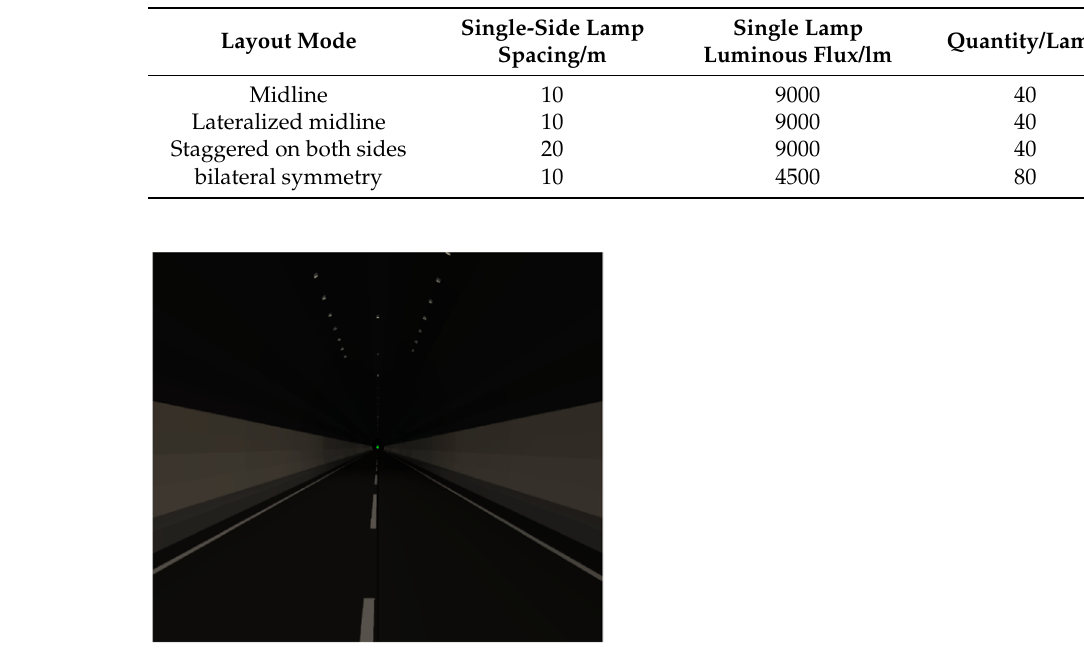
Figure 2. Simulation animation video screenshot (midline cloth light + 2 m + yellow + 3500 K). Image source: screenshot of the experiment animation. Table 5. Luminaire settings in the middle section.